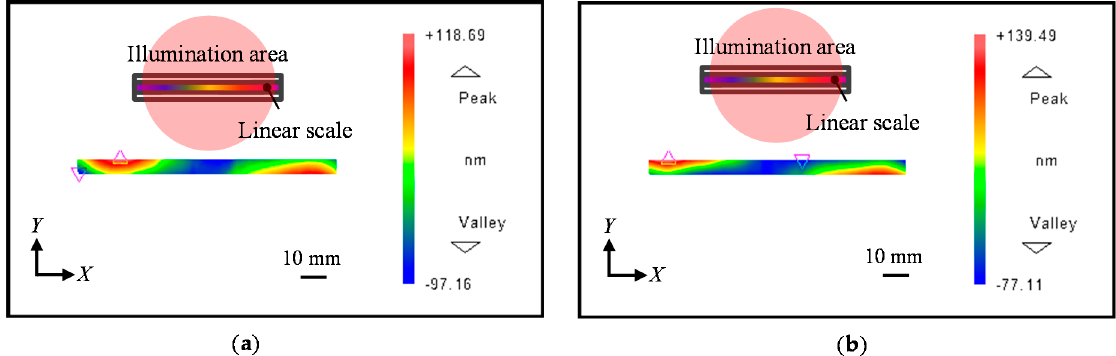
Figure 13. Measured first-order diffracted beams from the linear scale with one-shot measurement. ( a ) X -directional positive first-order diffracted beam; ( b ) X -directional negative first-order diffracted beam.